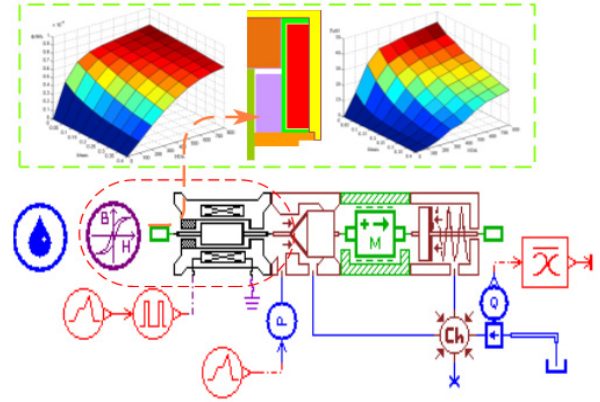
Figure 7. Digital valve model. Table 1. Parameter setting of main components of the digital valve model.